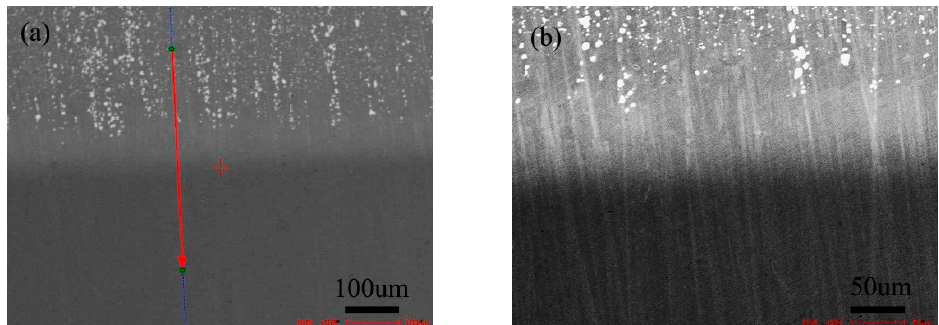
Figure 14. Microstructure of diffusion couple sample after 1000 °C/200 h heat treatment: ( a ) Composition line scan position of the sample and the upper side is 2Si alloy and Lower side is pure nickel, ( b ) the enlarged view of map a.